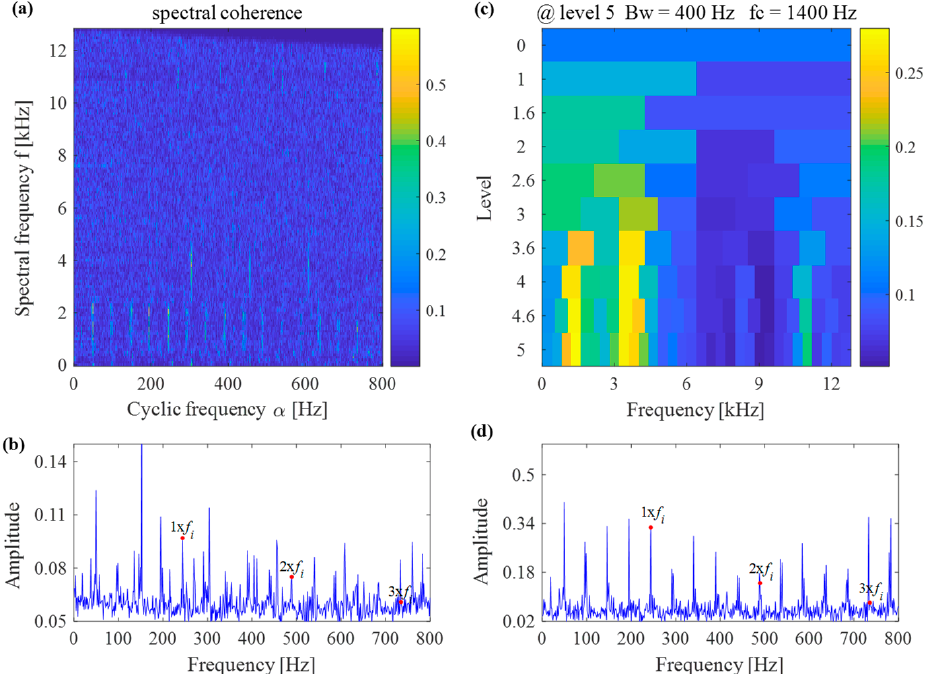
Figure 9. The EES and improved EES results of the signal as shown in Figure 8a. ( a ) Spectral coherence of the signal as shown in Figure 8a. ( b ) EES of the signal as shown in Figure 8a. ( c ) Optimal frequency band analysis result of the signal as shown in Figure 8a. ( d ) IEES of the signal as shown in Figure 8a.